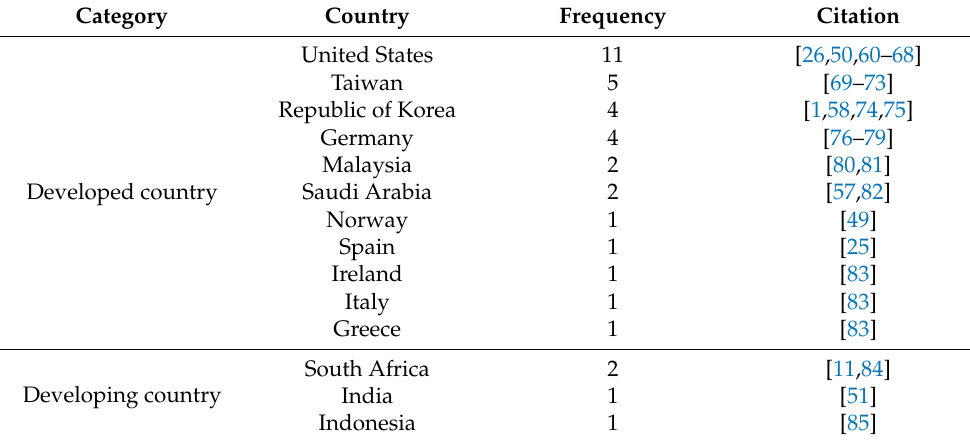
Table 1. Countries involved in the selected studies.